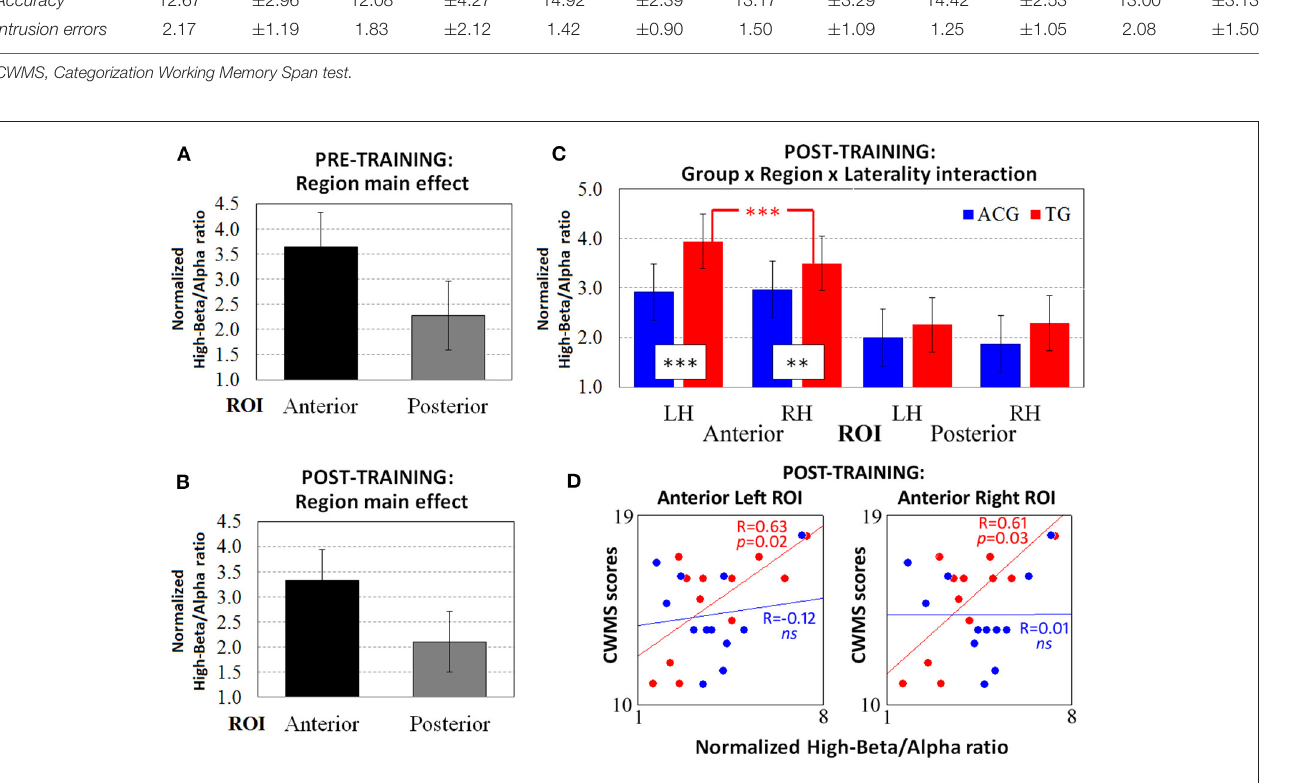
FIGURE 2 | The resting-state normalized high-beta/alpha index from the pre-training EEG data revealed only (A) the main effect of the region. ANOVA on the post-training EEG data showed both (B) the main effect of region and (C) the significant three-way Group × Region × Laterality interaction. The Spearman correlations between high-beta/alpha indices on both anterior ROIs and CWMS post-training performance (D) were significant for TG participants (red dots and lines) but not for ACG participants (blue dots and lines). *** p < 0.001, ** p < 0.01 Tukey HSD post-hoc comparisons. TG: Trained Group; ACG: Active Control Group; LH: Left Hemisphere; RH: Right Hemisphere; CWMS: Categorisation Working Memory Span